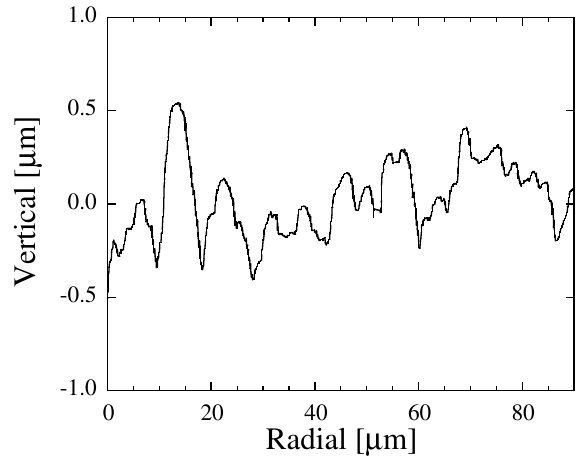
FIG. 6. A surface height plot of the scandate cathode shown in Fig. 5 as a function of the radial coordinate. The radial ‘‘origin’’ does not correspond to the center of the